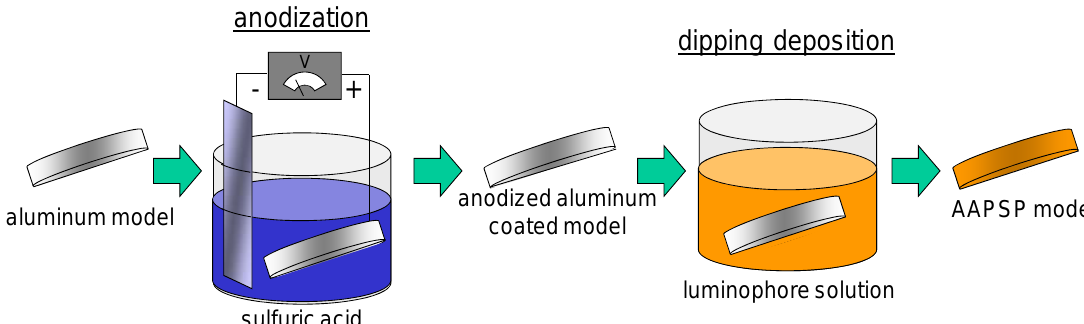
anodized aluminum coated